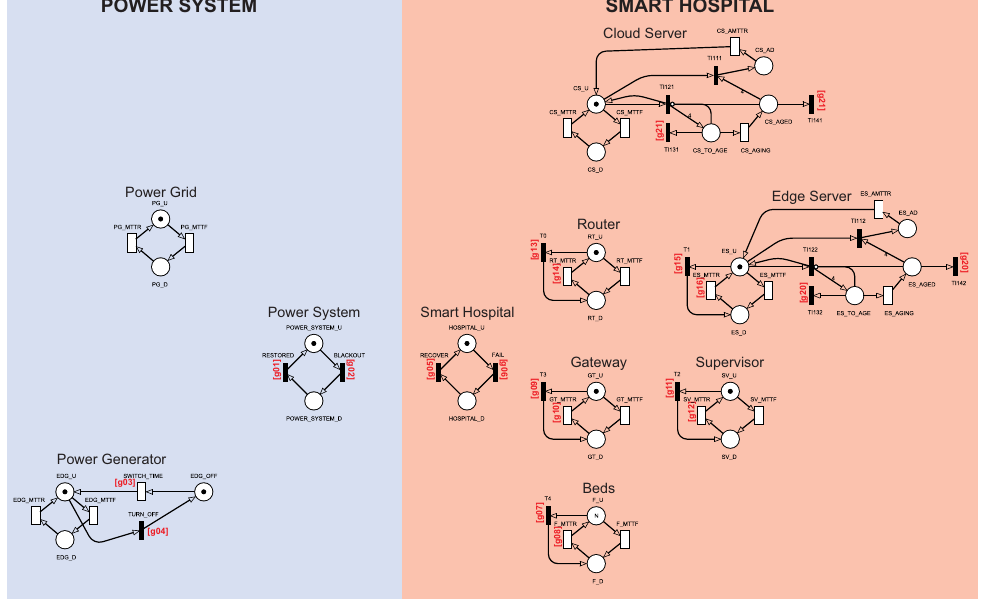
Figure 2. SPN model